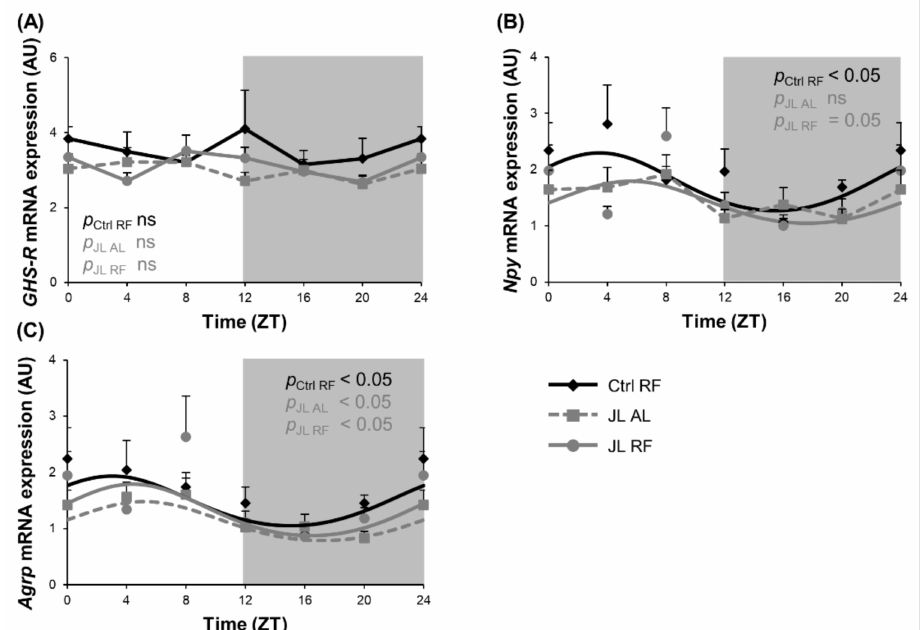
Figure 5. Time restricted feeding prevents the rhythmicity in hypothalamic Npy mRNA expression that is abolished by chronic jetlag. ( A ) GHS-R, ( B ) Npy and ( C ) Agrp mRNA expression in the mouse hypothalamus of control mice fed a TRF diet (Ctrl RF), jetlagged mice fed ad libitum (JL AL) and jetlagged mice fed a TRF diet (JL RF) ( n = 8mice per time point per group). The fitted cosine curve determined by cosinor analysis (period = 24 h) are shown in Ctrl RF, JL AL and JL RF mice. The dark phase is shaded grey. Statistics: Non-linear regression (Proc NLIN). ns = not significant. p values refer to probability values for the best fitting cosine